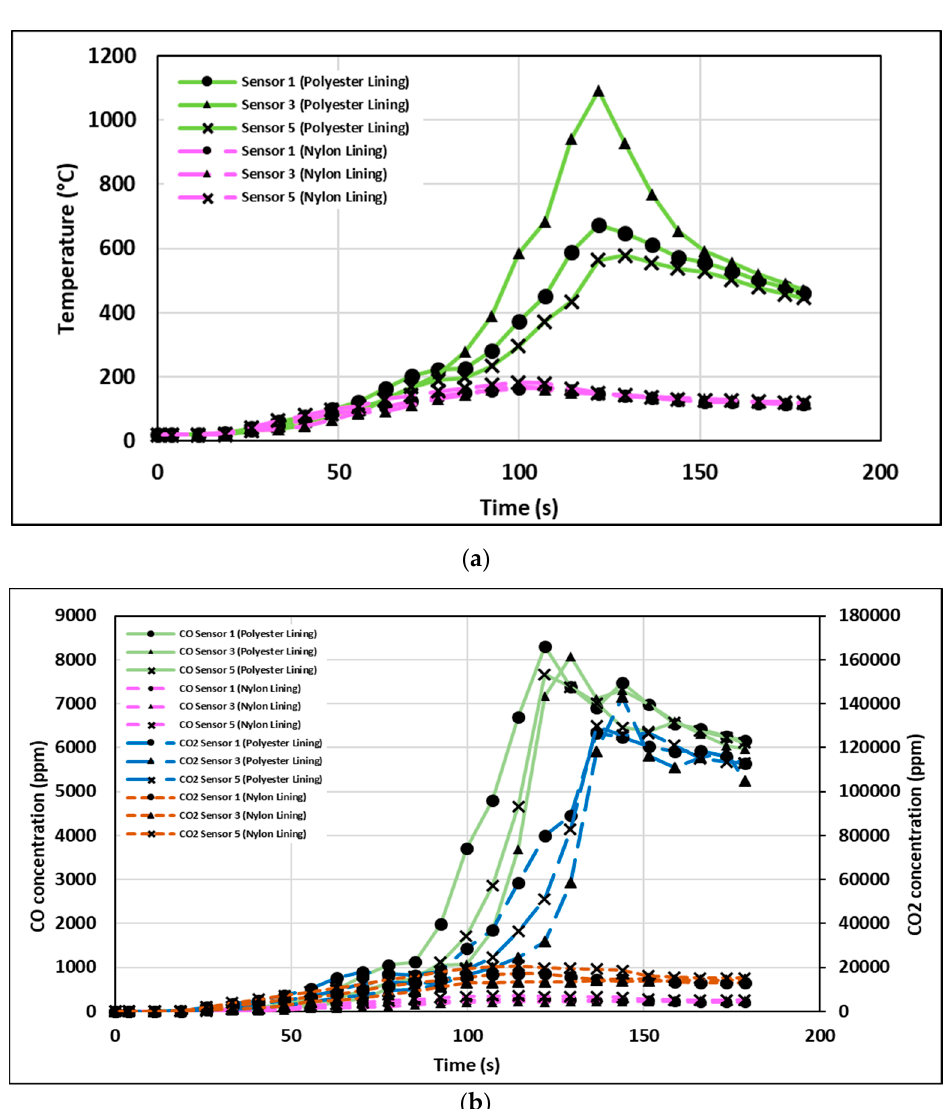
Figure 15. Temperature variations along the central plane of carriage after 40 s, 80 s and 120 s for ( a ) PN6 model and ( b ) PLY model.